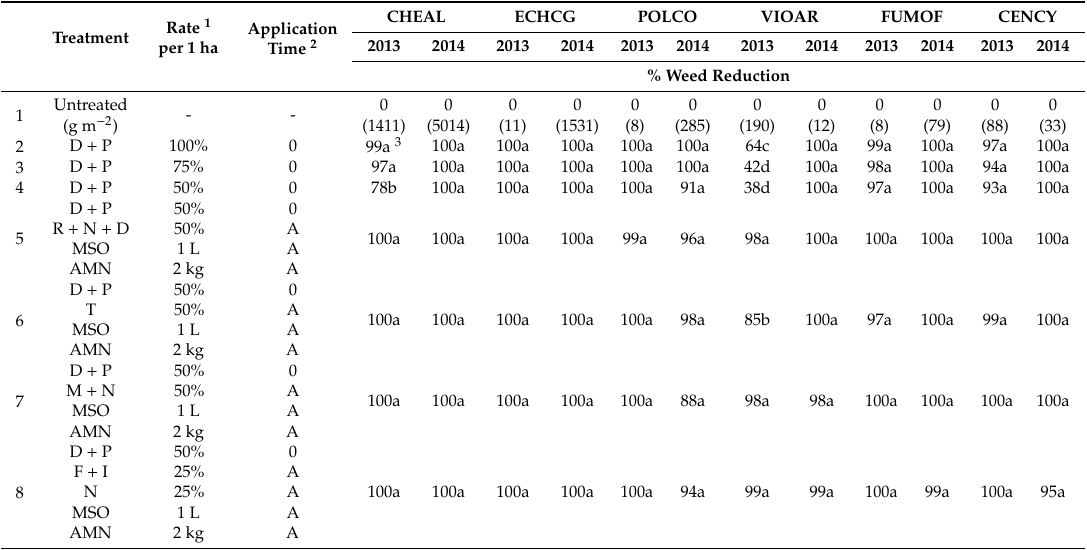
Table 3. Influence of dimethanamid + pendimathalin and their mixtures with postemergence herbicide on weed